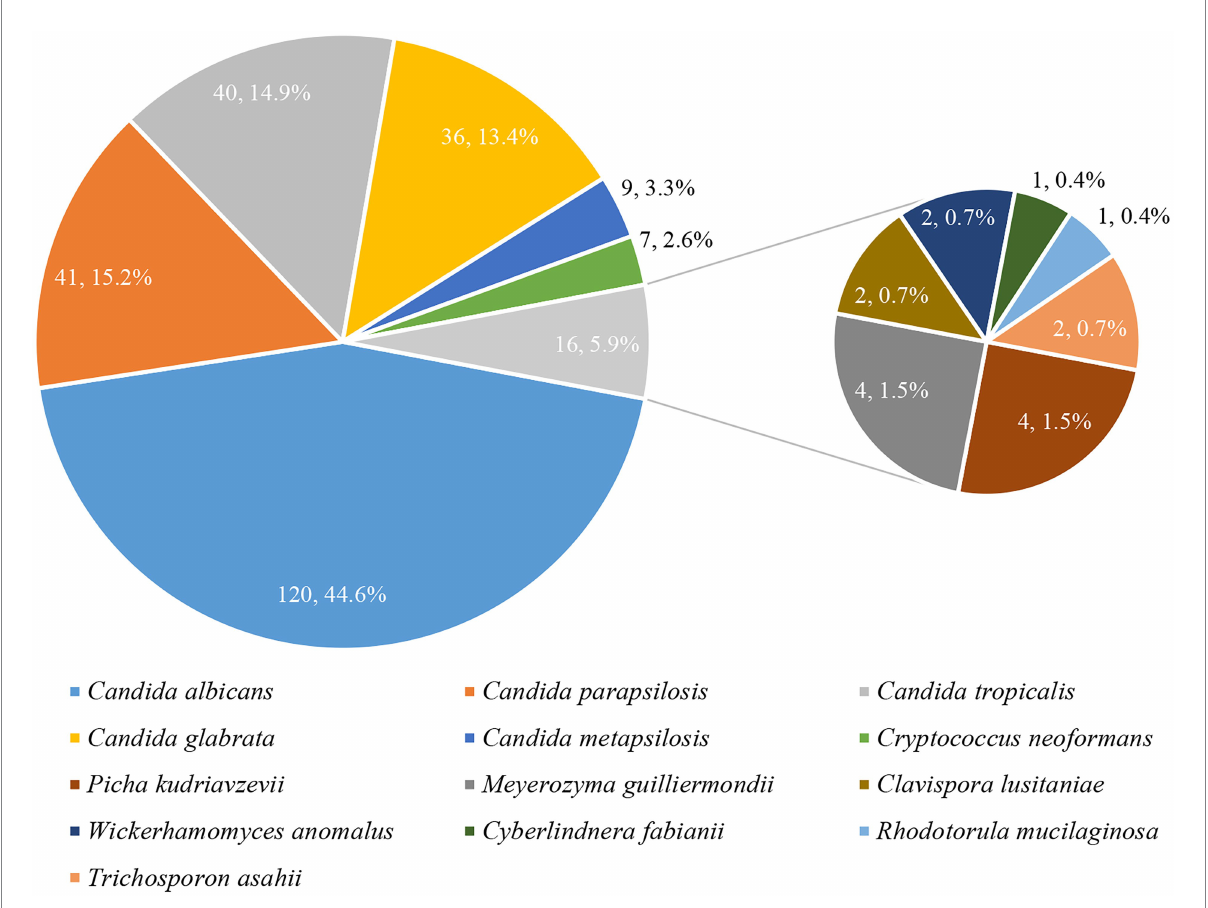
FIGURE 2 Species distribution of common and less common yeast